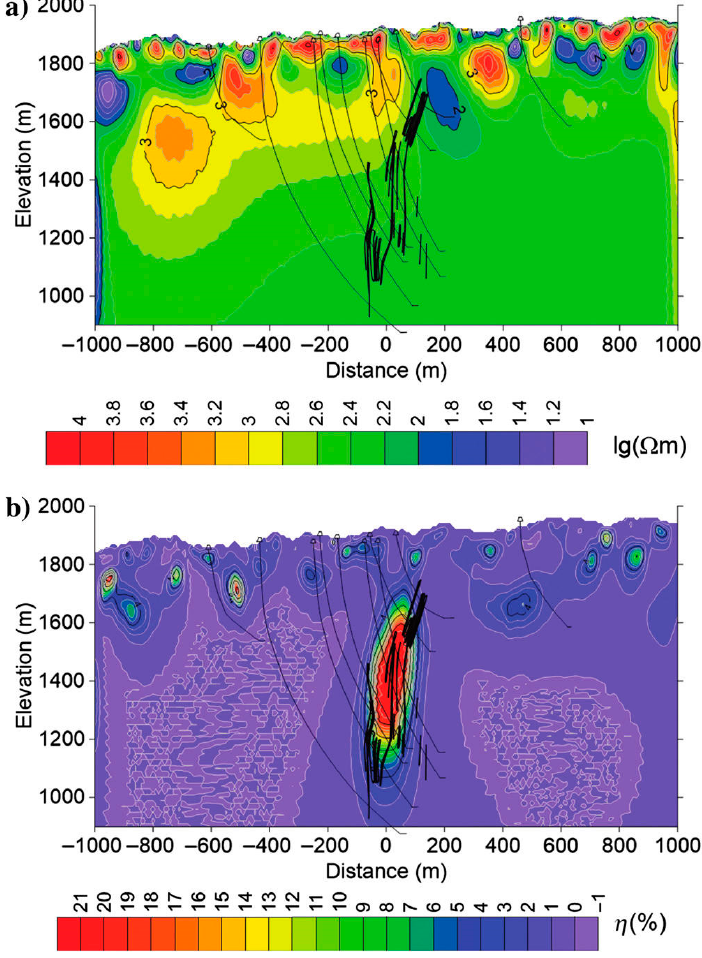
Figure 34. VMS Cu–Pb–Zn ore bodies imaged by SSIP. ( a ) The 2D resistivity tomogram. ( b ) The 2D IP chargeability tomogram. The chargeability (M = η ) is here expressed in % rather than in a fraction from 0 to 1. Both tomograms are derived from the apparent complex resistivity data at a frequency of 0.41 Hz. The thick black lines show the shape and location of the Cu–Pb–Zn ore bodies defined by the eight wells, which are projected onto the plane of the tomogram (modified from [105]).